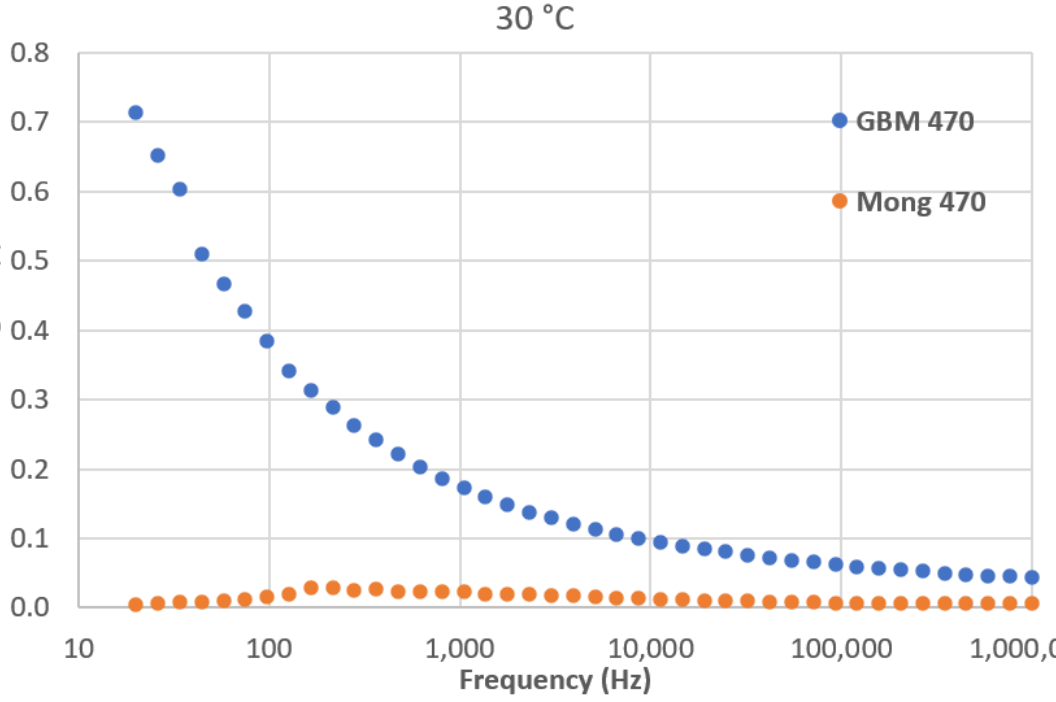
Figure 11. Loss tangent dependence on frequency at room temperature for coatings sprayed with SD 470.